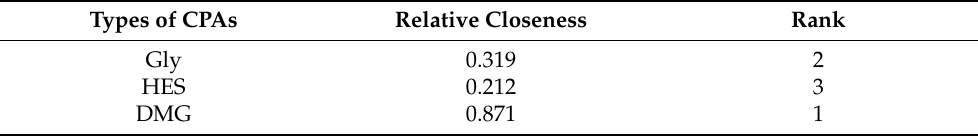
Table 2. The relative closeness and rank by